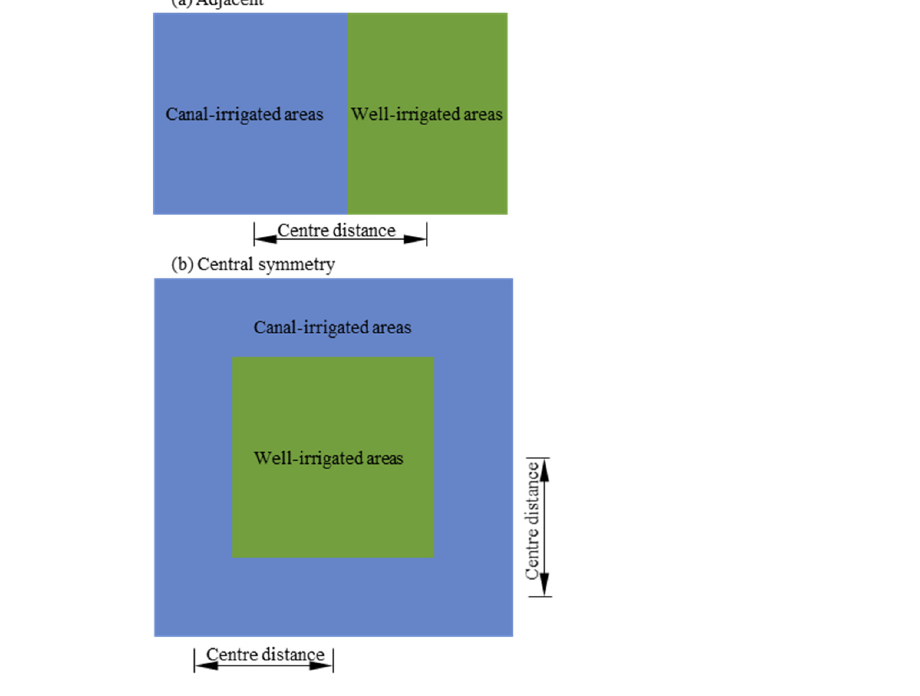
Figure 3. Real-world spatial locations between canal- and well-irrigated areas, ( a ) the well-canal irrigated areas are adjacent, ( b ) the well-canal irrigated areas with central symmetry. Table 1. Different sizes of canal- and well-irrigated areas in two special spatial